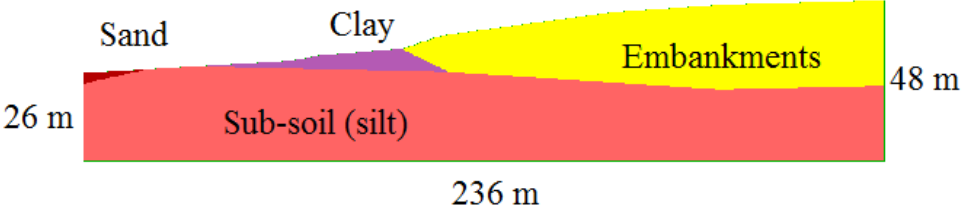
Figure 6. Model 2D and location of soil layers in slope.